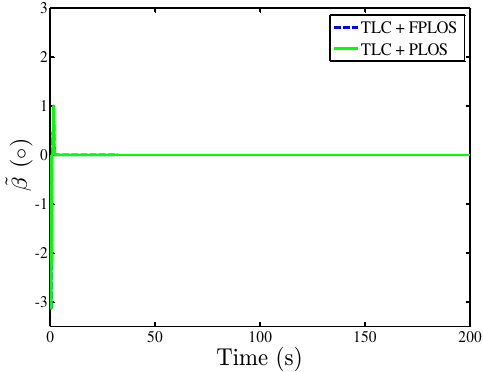
Figure 8. Sideslip angle estimation errors ˜ β .